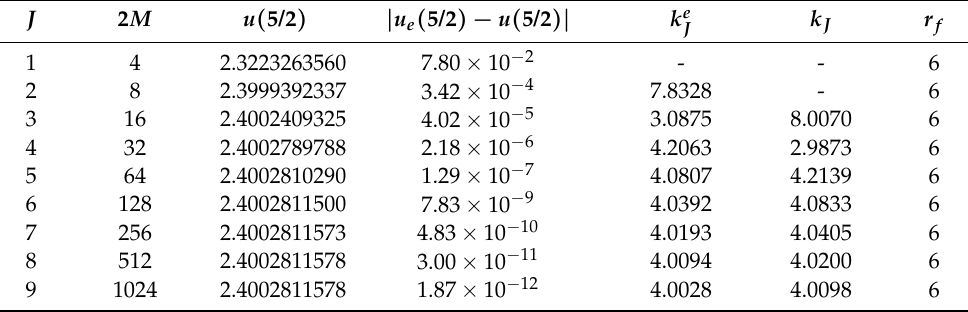
Table 4. Solutions to (18) where u e ( 5/2 ) = 2.400281157801 using HOHWM.